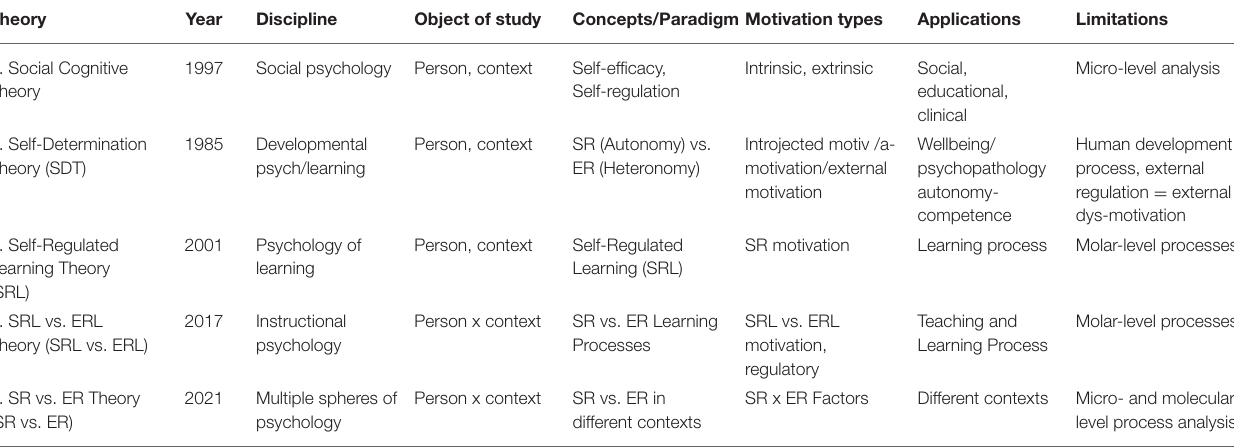
TABLE 1 | Summary chart of the theoretical approaches toward Self-Regulation analyzed in this paper.